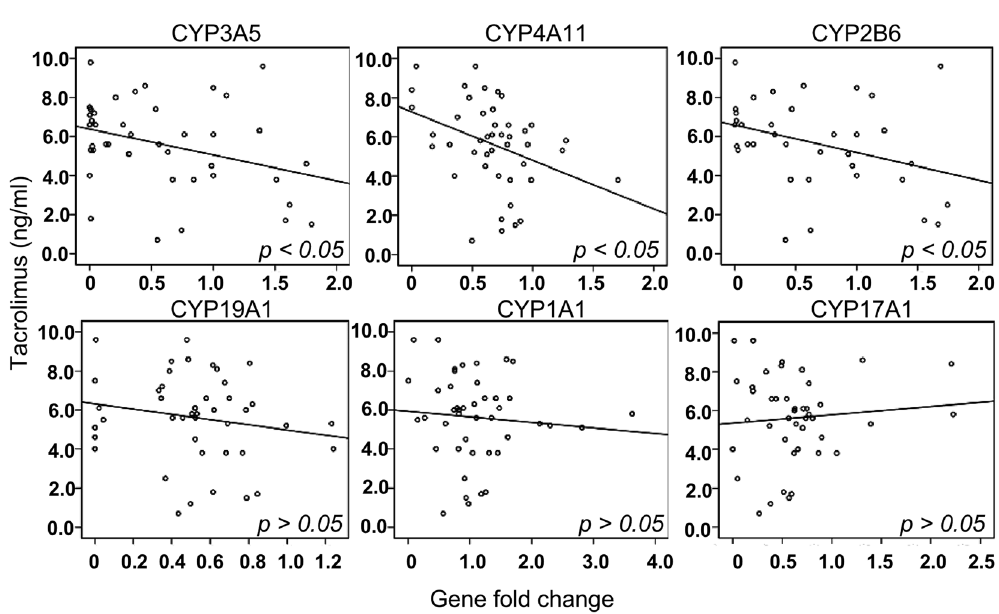
Figure 4. Linear regression analysis of the correlation between the blood tacrolimus level and the indicated gene expression level in liver transplant receipts.